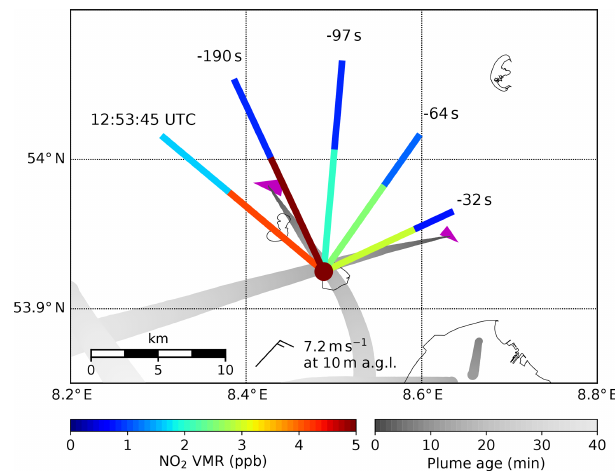
Figure 5. Map showing a zoom in onto panel 10 of Fig. 4 and the four previous MAX-DOAS observations, which have been mea- sured between 30s and 3min before the current observation. Hori- zontal light path lengths (UV path and (cid:49)L ) and corresponding path- averaged volume mixing ratios of NO 2 are shown as colored lines and the in situ NO 2 VMR as a colored dot at the location of the in- strument. Magenta triangles show the ship position and course, with larger triangles for larger ships. The modeled plumes are shown in gray, with the lightness of the gray shading representing the plume age. Please keep in mind that ship and plume position were differ- ent for the past measurements. Wind direction and speed are shown with a meteorological wind